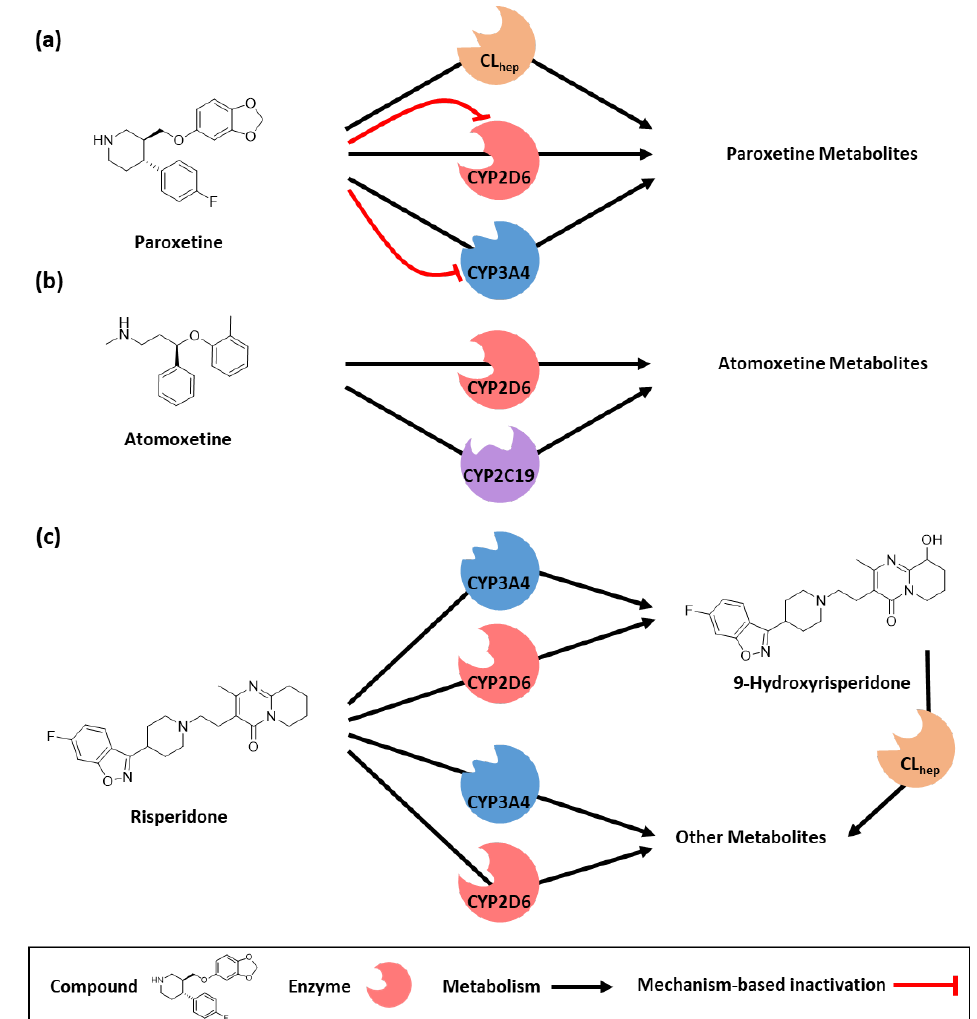
Figure 2. Implemented metabolic pathways for the modeled compounds. ( a ) Paroxetine is metabolized via CYP2D6, CYP3A4, and an unspecific clearance process [22]. Moreover, paroxetine is a mechanism-based inhibitor of CYP2D6 and CYP3A4 resulting in an irreversible auto-inhibition of paroxetine metabolism [23,55]. Paroxetine metabolites were not included as model compounds. ( b ) Atomoxetine is metabolized via CYP2D6 and CYP2C19 [24]. Atomoxetine metabolites were not included as model compounds. ( c ) Risperidone is metabolized to its active metabolite 9-hydroxyrisperidone via CYP2D6 and CYP3A4 [56]. Moreover, other metabolites are formed via CYP2D6- and CYP3A4-mediated metabolism [56]. 9-Hydroxyrisperidone is metabolized via an unspecific hepatic clearance process. Other risperidone metabolites were not included in the model. CL hep : unspecific hepatic clearance, and CYP: cytochrome P450.